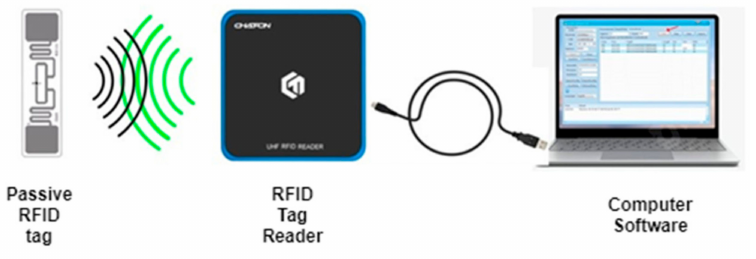
Figure 8. Schematic block diagram of the RFID tag